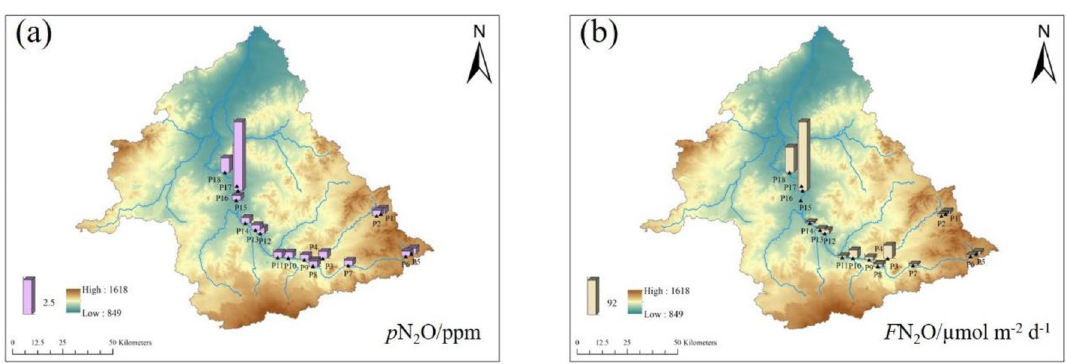
Figure 9. Spatial variation of p N 2 O ( a ) and F N 2 O ( b ) in the Xilin River in 2018 (generate by Arcgis